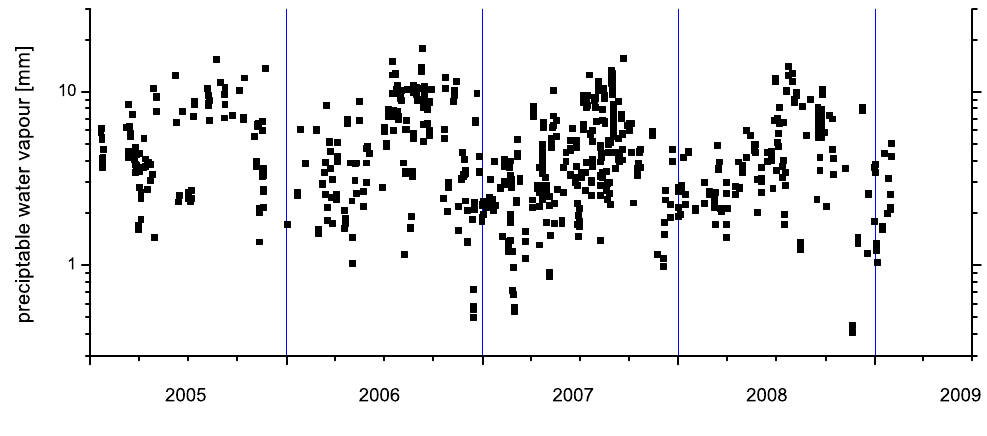
Fig. 3. Time series of Iza˜na’s FTIR PWV measurements between 2005 and